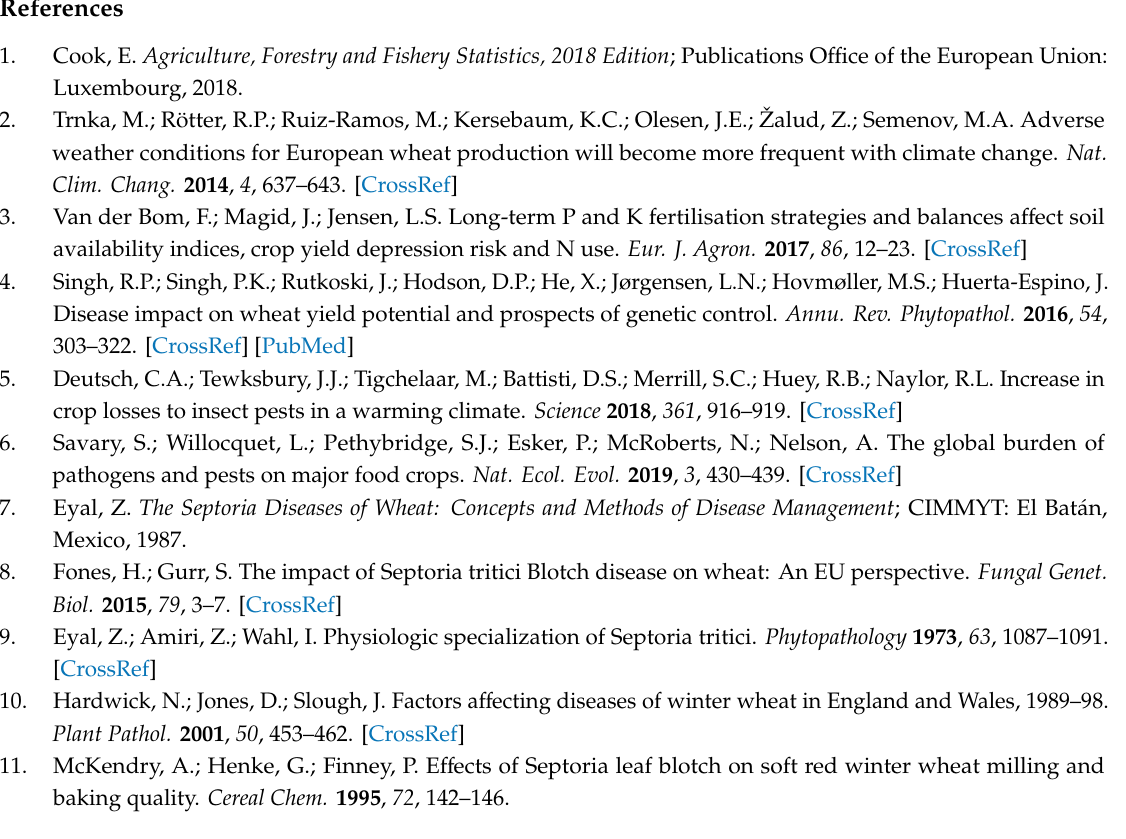
BLUPs of the eight haplotype founder e ff ects in the additive model, along with the LOD curve on the respective chromosomes. The title of each figure represents QTL and the dataset in which it was detected. The LOD scores of the genome scans represented here were determined by Haley-Knott regression. Table S1 . Phenotypic data for STB, flowering time and plant height for the NIAB Elite MAGIC population collected from di ff erent datasets. Table S2 . Summary of LOD scores for QTL mapping of NIAB Elite MAGIC population across di ff erent datasets. LOD scores were obtained from three di ff erent methods by Haley-Knott (hk) regression, a linear mixed model (lm) using standard kinship matrix, and a linear mixed model using leave one chromosome out (LOCO) kinship matrix. Table S3 . Summary of the flowering time and plant height QTL identified using the Haley-Knott regression method in the NIAB Elite MAGIC population grown in the field under natural STB infection. QTL were compared with flowering time and plant height data for NIAB Elite MAGIC population from the previously published study by Scutari et al. [84]. Table S4 . Functional annotation of peak marker of the septoria tritici blotch (STB) resistance QTL identified in this study. Table S5 . Comparison of physical positions of the QTL identified in the present study with those reported